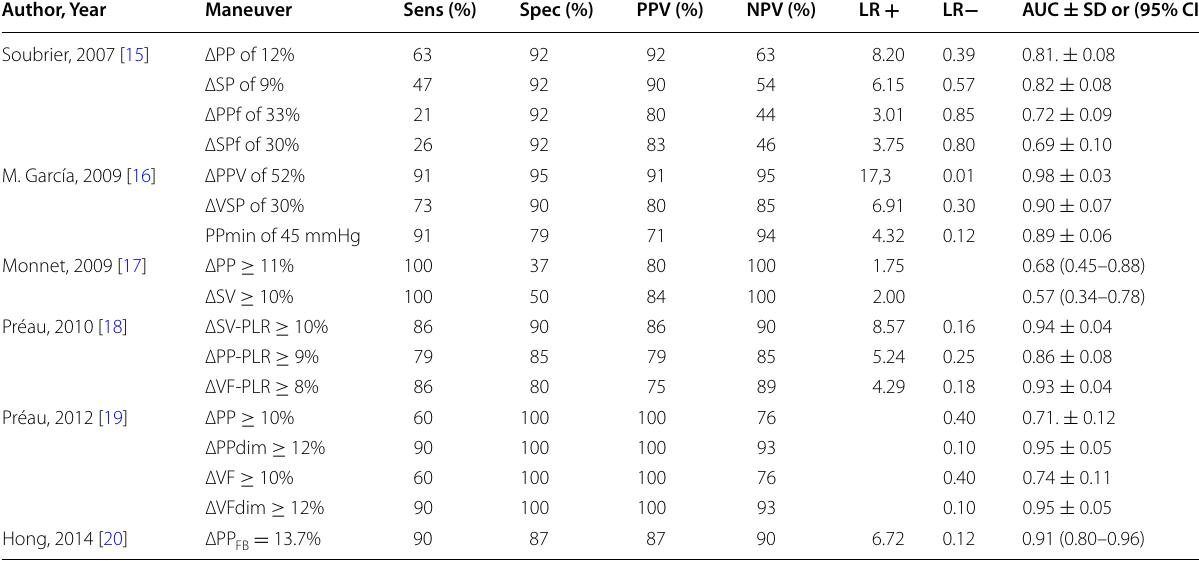
Table 3 Performance of included studies that addressed pulse pressure variation to predict fluid responsiveness in spon- taneously breathing patients